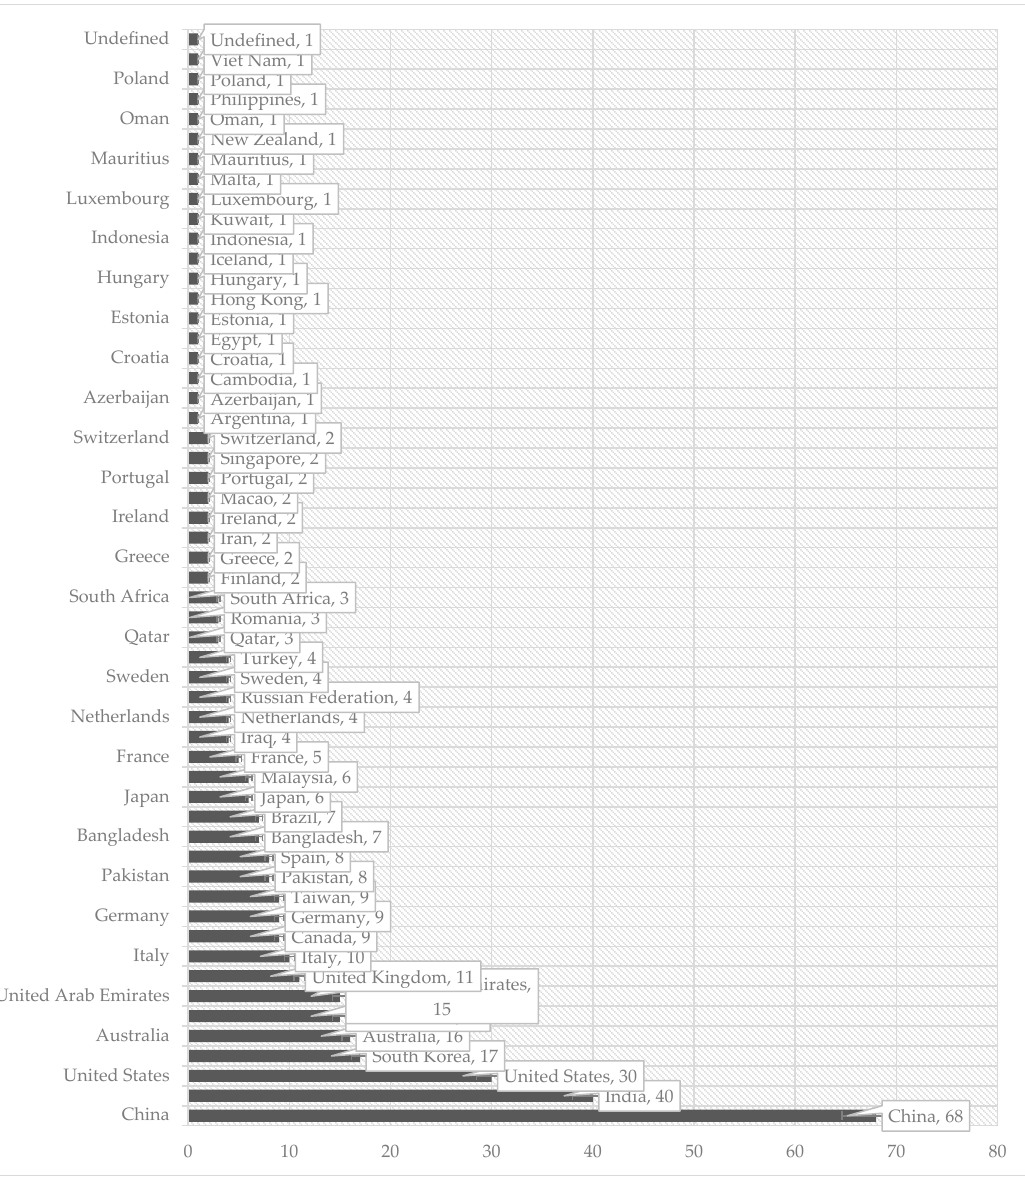
Figure 3. Distribution of authors by country.